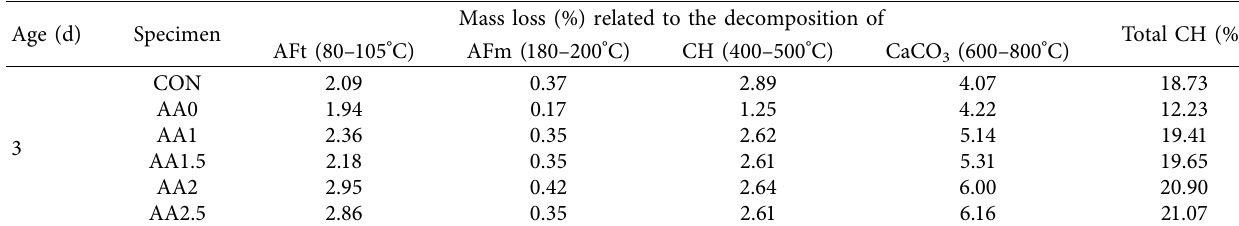
Figure 11: TGA-DTG thermograms of 3 d and 7d pastes. (a) 3d pastes; (b) 7 d pastes. Table 4: Contents of hydration products of 3d and 7d